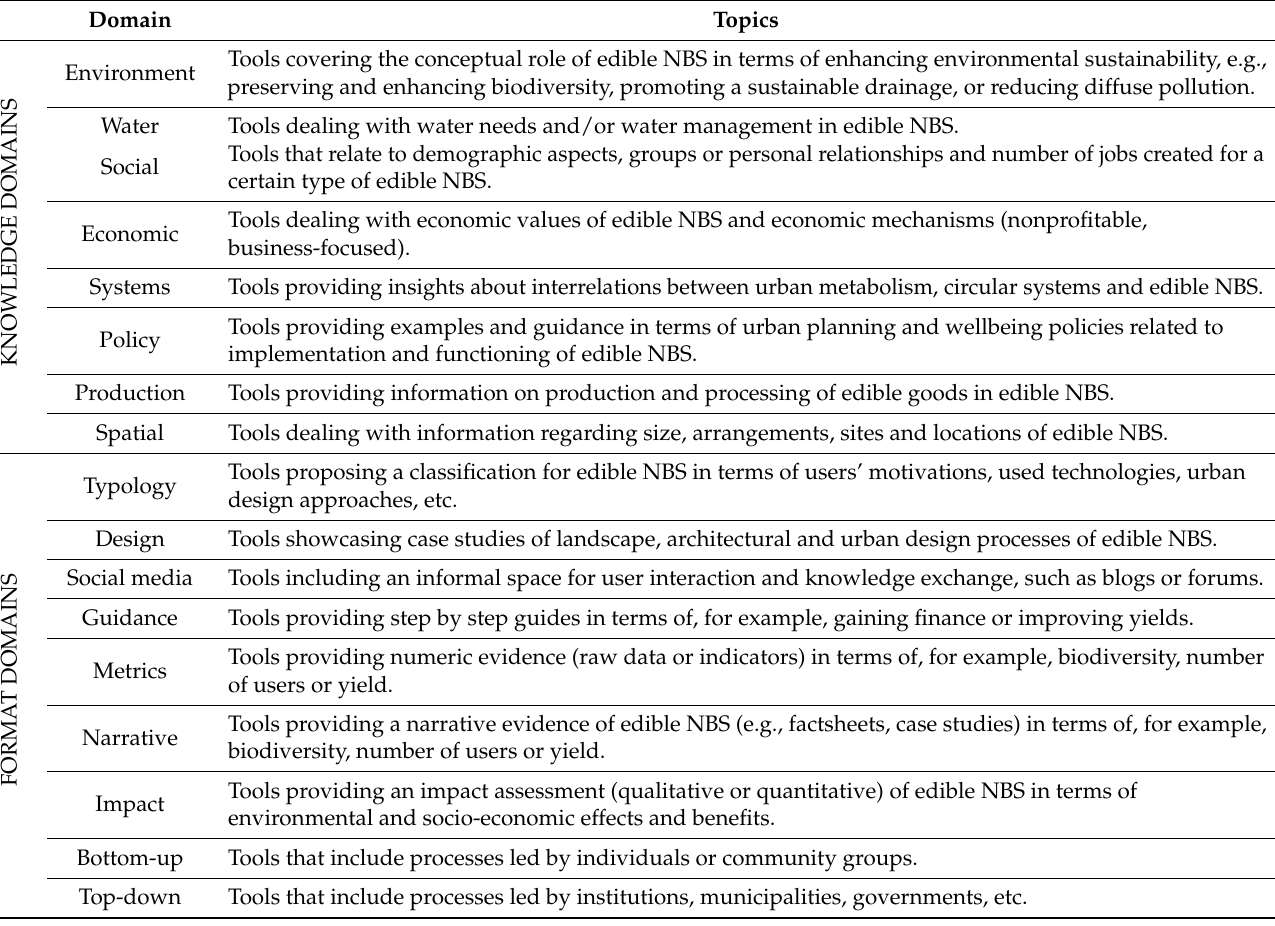
Table 1. Description of matrix categories used to classify the analysed